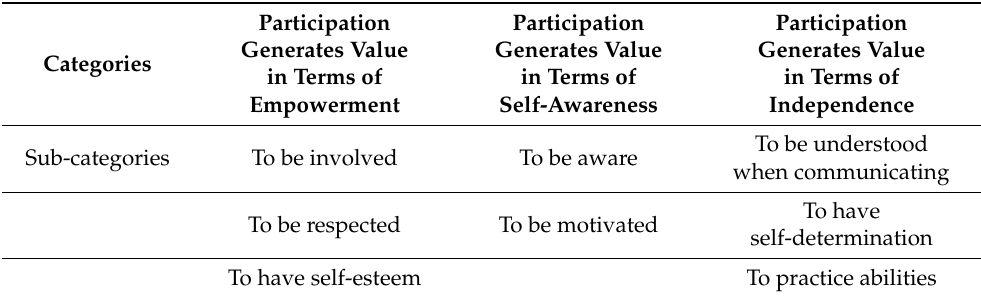
Table 4. Overview of categories and sub-categories describing parents’ perceptions of the value of children’s participation in pediatric rehabilitation